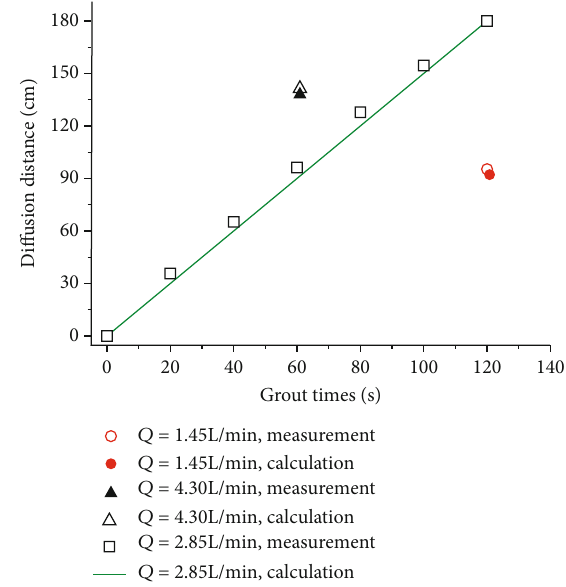
Figure 7: The grout di ff usion distance with